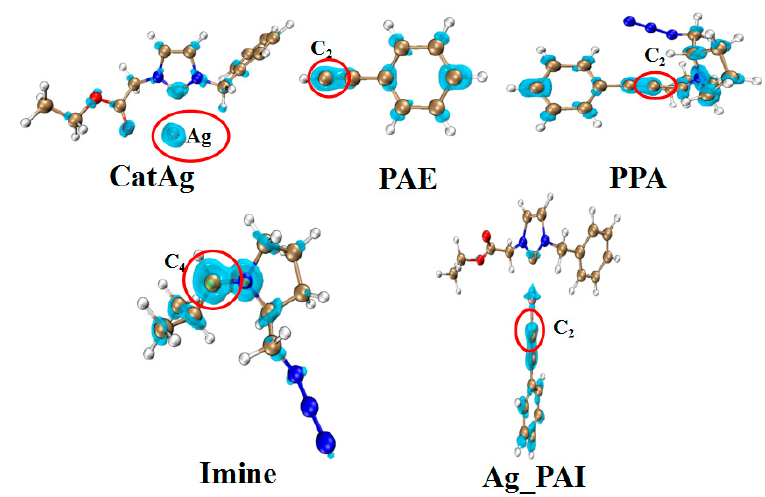
Figure 11. Isosurface diagram of the Fukui function for Ag (CatAg, f + ), C 4 (Imine, f + ), and C 2 ( f − ) in PAE, PPA, and Ag_PAI.